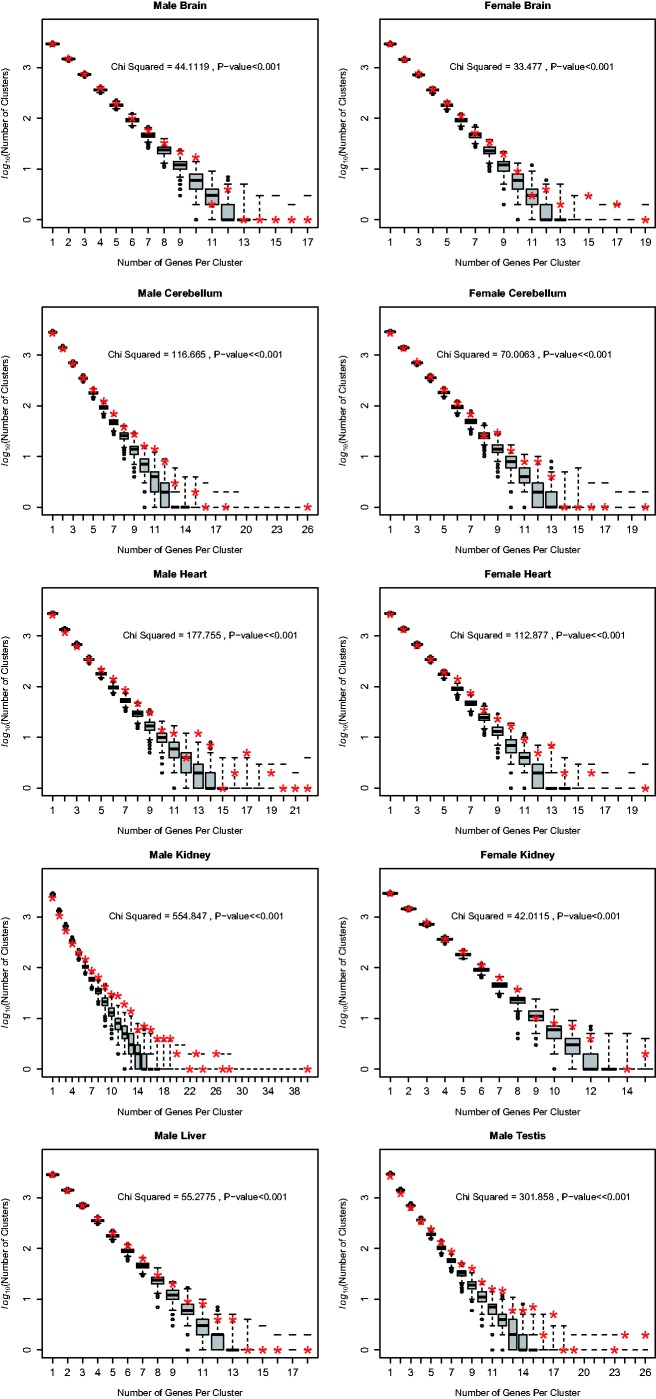
Numbers of clusters of a given size compared to that expected under a random null. Observed number of clusters including certain number of genes is shown by red stars, boxplots show variation across number of clusters in 1,000 random sets.